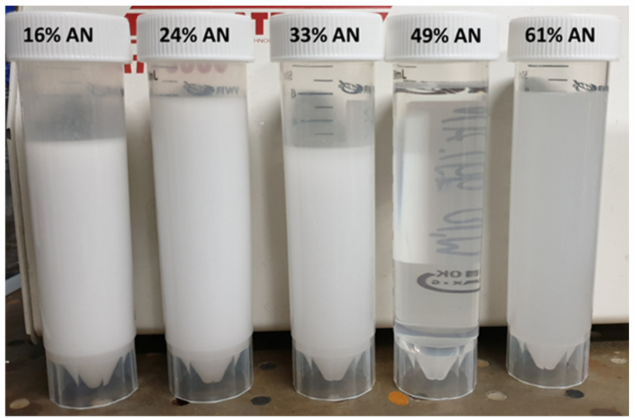
Figure 3. The investigated W 1 /O emulsions with the respective ammonium nitrate (AN) concentrations.